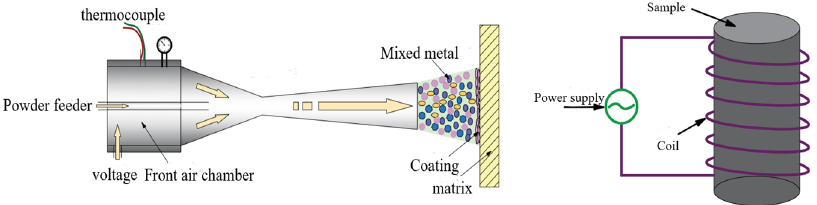
Figure 2. The principle of the HEA coating synthesized via cold-spray-assisted induction remelting.